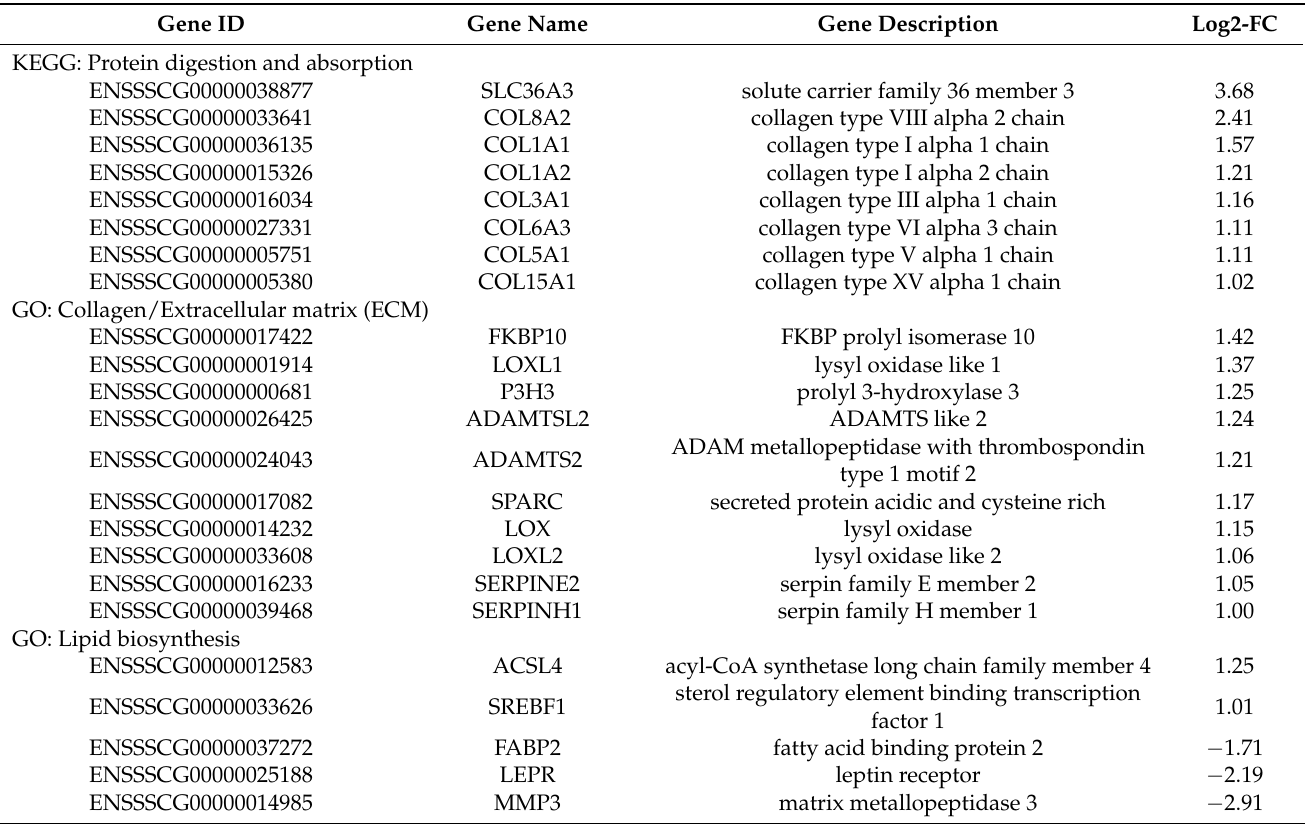
Table 4. DEGs in the liver of the ZQ-1 g pigs in comparison to the control